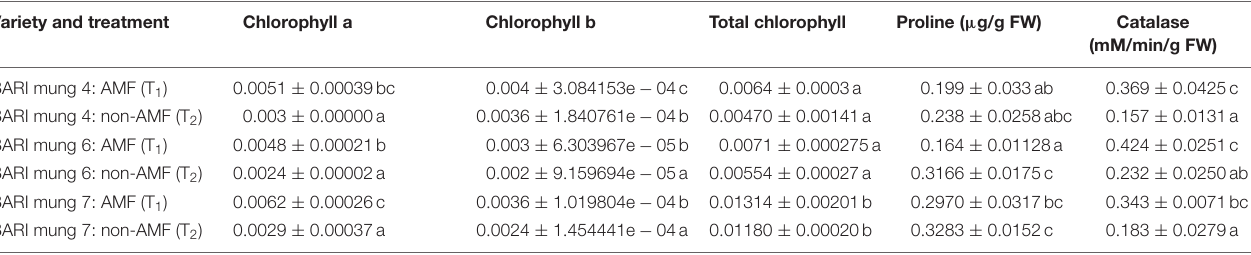
TABLE 5 | Mean comparison of AMF effects on antioxidant defense activities in BARI mung 4, BARI mung 6, and BARI mung 7 genotypes in soils with an arsenic concentration of 30 mg kg − 1 . Variety and treatment